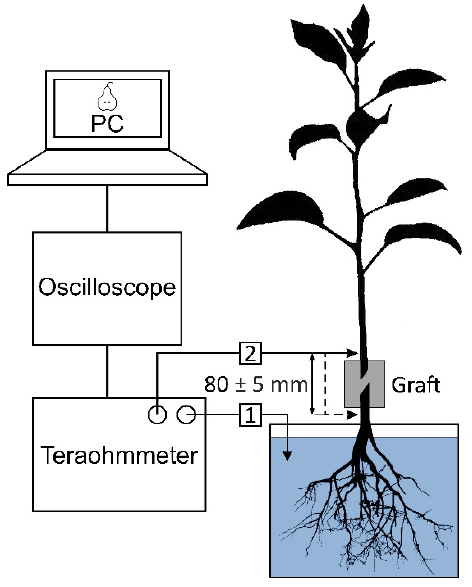
Figure 12. Measurement of the electrical resistance of the graft in a pear seedling 6 months after treatment. The seedling was immersed in the stock solution, and the measuring electrodes were made of silver and coated with a layer of silver chloride. 1—electrode immersed in stock solution; 2—electrode inserted into the cambian layer of the bark. The resistance of the graft was determined by calculating the difference in resistance between two points: when (2) located above the graft and located below it. Number of samples in each group was 5, and number of measurement repetitions was 5.